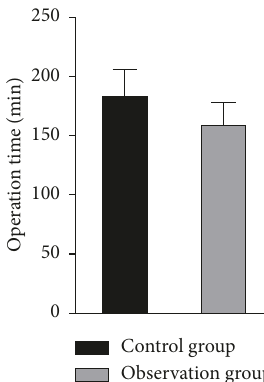
Figure 2: Comparison of oxyhemoglobin saturation monitoring between the two groups. Note: compared with the control group, P 0 . 05. <